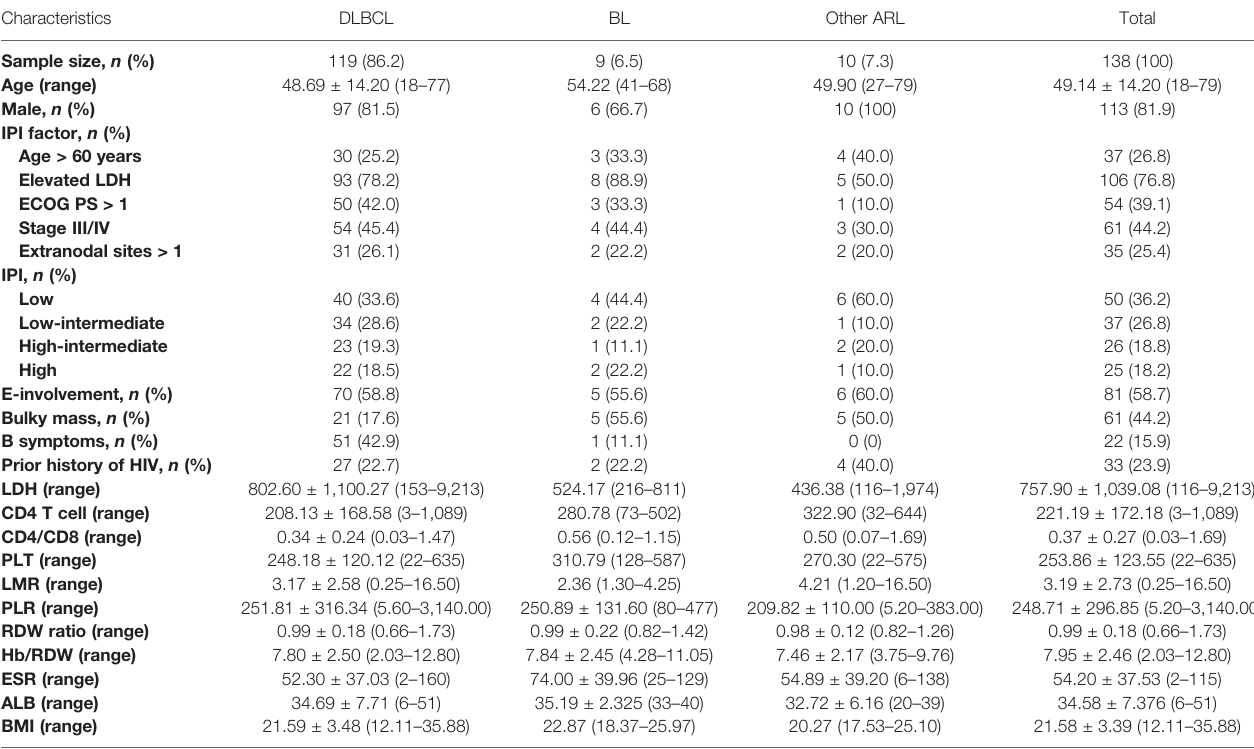
TABLE 1 | The demographics and clinical characteristics of AIDS-related lymphoma (ARL) patients ( n = 138). Characteristics DLBCL BL